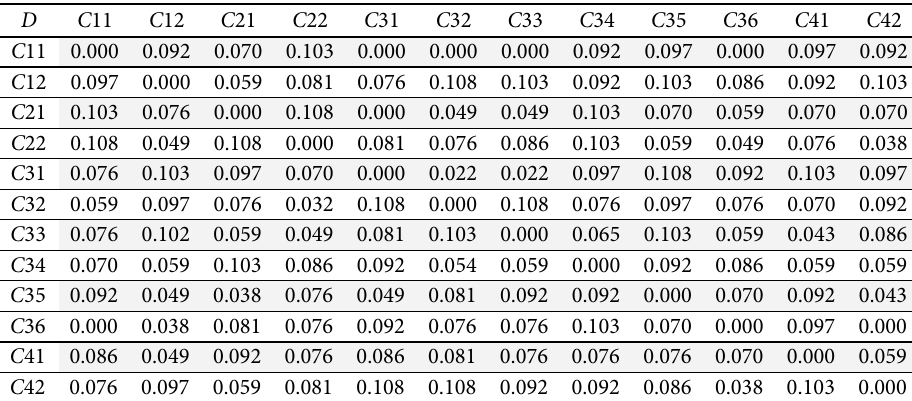
Table 4. Normalized direct-influence matrix D for